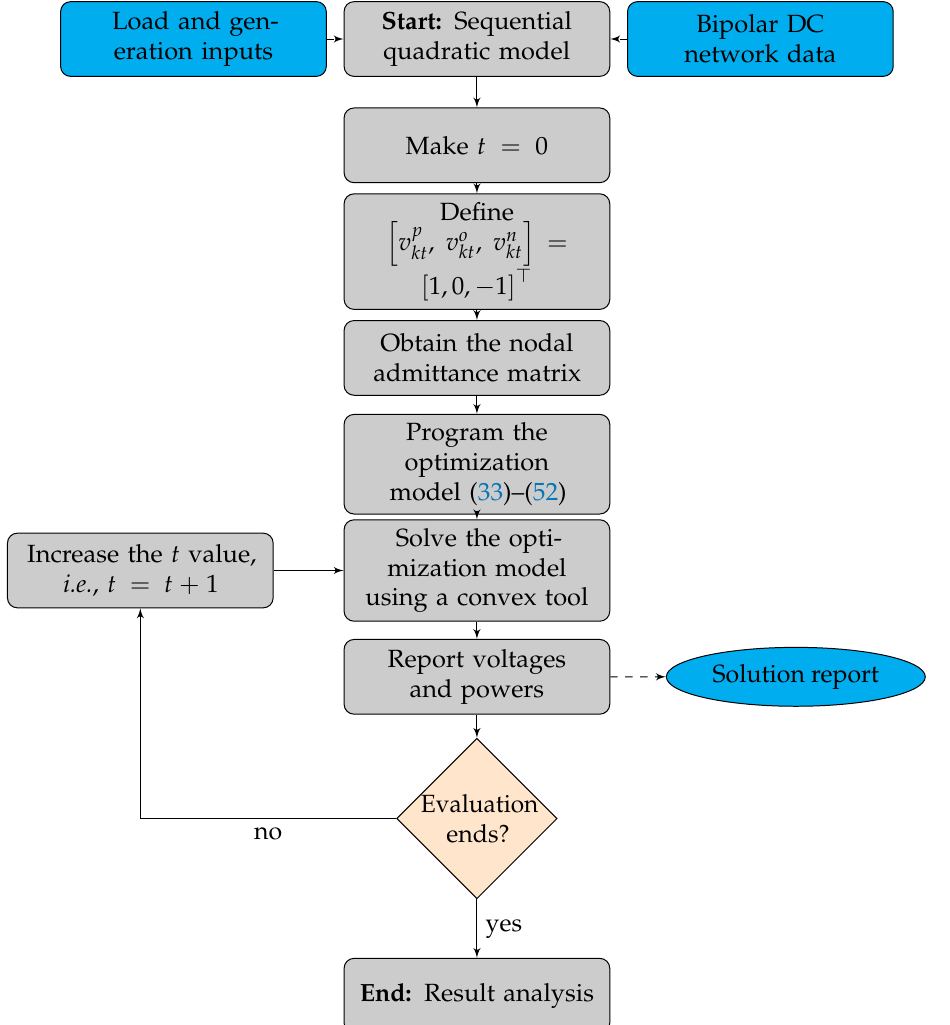
Figure 1. Recursive solution for the proposed quadratic convex model